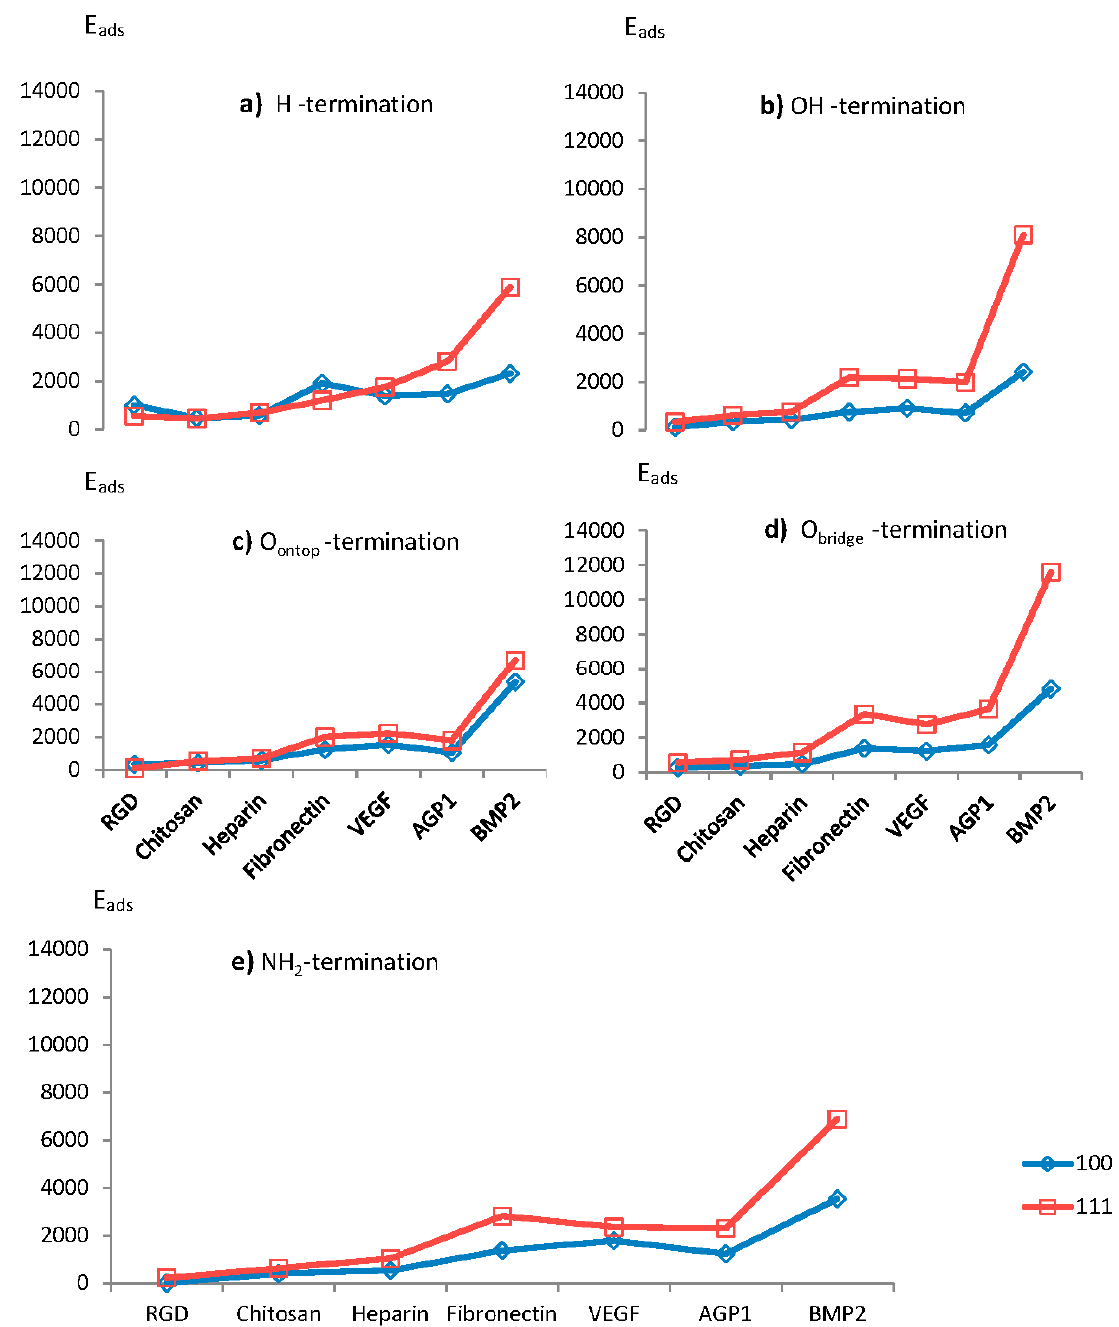
Figure 2. Adhesion energies (in kJ/mol) for various growth factors attached to diamond (100) and (111) surfaces, being terminated with ( a ) H, ( b ) OH, ( c ) O ontop , ( d ) O bridge , or ( e ) NH 2 species. The trends in adhesion energy as a function of surface termination type, were also observed to be very similar for the AGP1 protein: O bridge > H > NH 2 > OH > O ontop (diamond (111)) and O bridge > H > NH 2 > O ontop > OH (diamond (100)-2x1). It is here only the O ontop –termination that will break an otherwise perfect similarity in trend between these two diamond